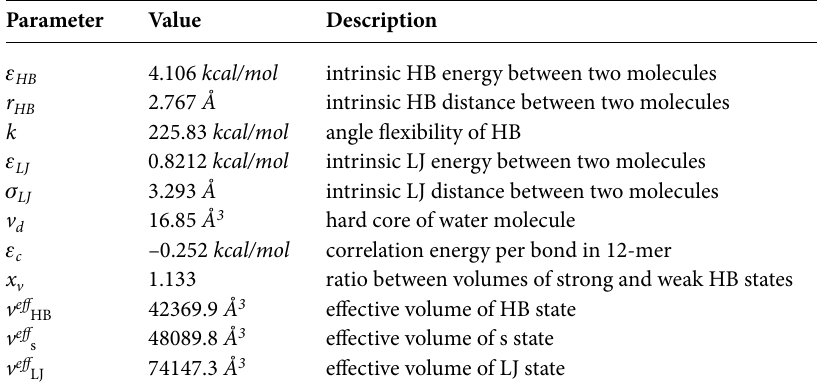
Table 1 : To obtain the parameters, the intrinsic HB energy and HB distance are fixed while all other parameters were optimized. Parameter Value